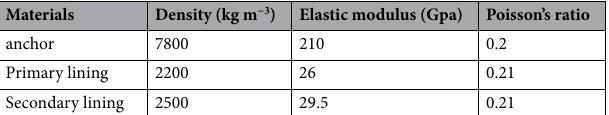
Table 1. The physical parameters of anchor, primary lining, and secondary lining.